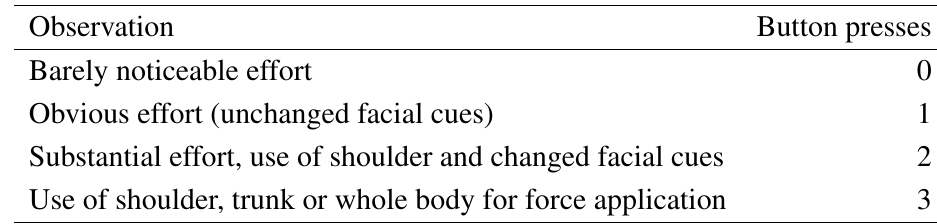
Table 4. Modified Moore-Garg Strain